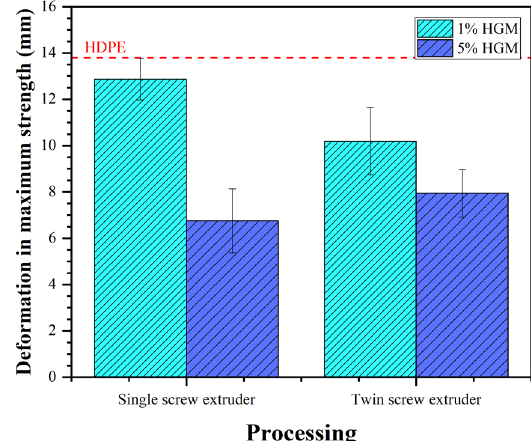
Figure 6. Maximum strength x Processing